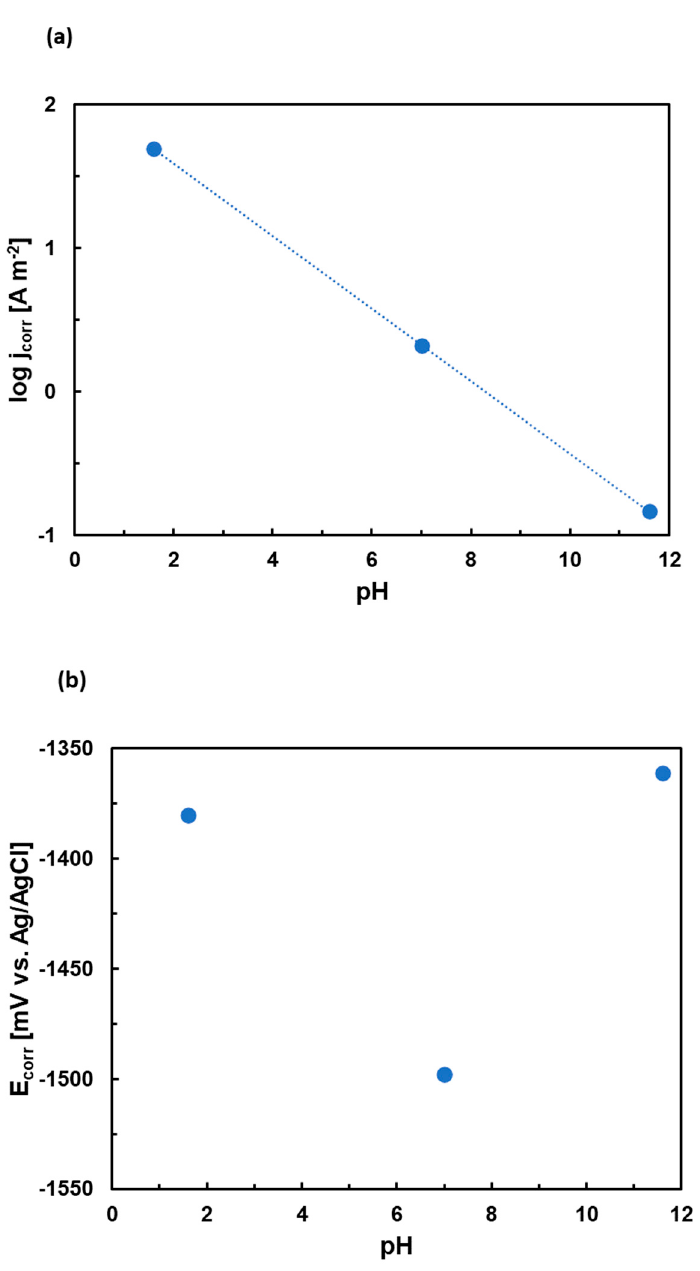
Figure 7. The dependence of corrosion currents ( a ) and corrosion potentials ( b ) of the as-cast Mg 2 Sn alloy on the pH of the solution.